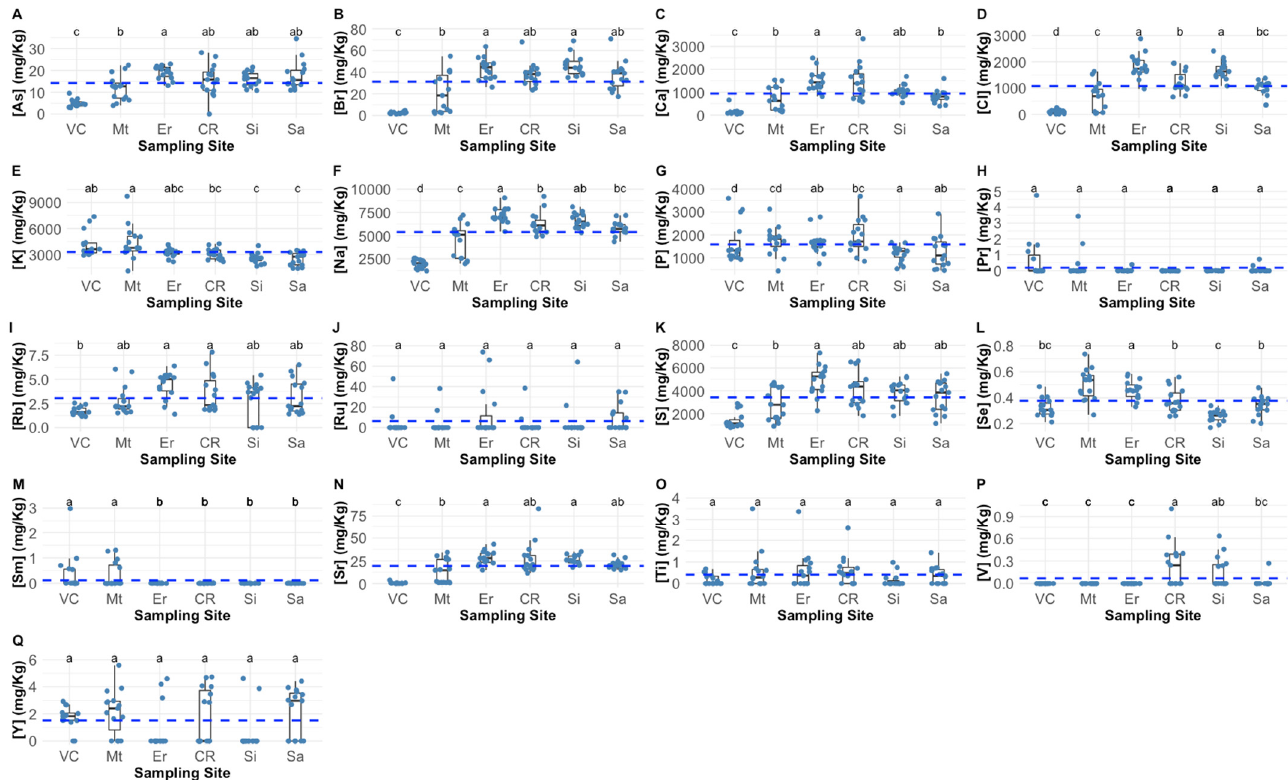
Figure 1. Arsenic, ( A ), bromine ( B ), calcium ( C ), chlorine ( D ), potassium ( E ), sodium ( F ), phosphorous ( G ), praseodymium ( H ), rubidium ( I ), ruthenium ( J ), sulphur ( K ), selenium ( L ), samarium ( M ), strontium ( N ), titanium ( O ), vanadium ( P ) and yttrium ( Q ) Pollicipes pollicipes peduncle concentrations (wet weight) of the individuals collected at the six sampling sites (VC — Viana do Castel; Mt — Matosinhos; Er — Ericeira; CR — Cabo Raso; Si — Sines; Sa — Sagres; dotted blue lines represent the average value detected for the whole dataset). Statistical letters denote significant differences between sampling sites at p < 0.05.